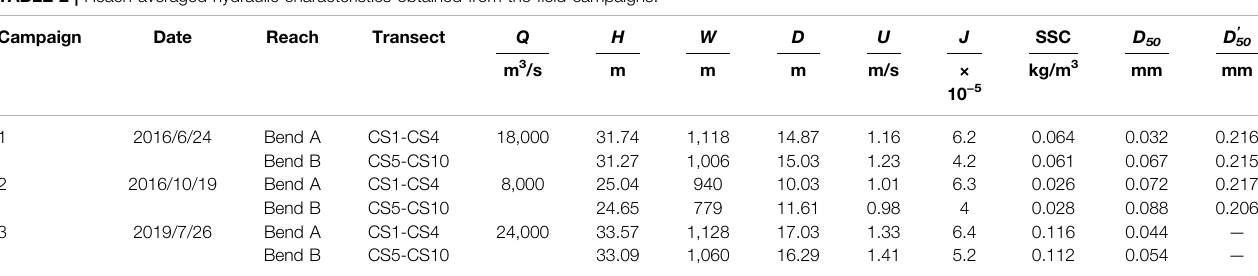
TABLE 2 | Reach-averaged hydraulic characteristics obtained from the fi eld campaigns. Campaign